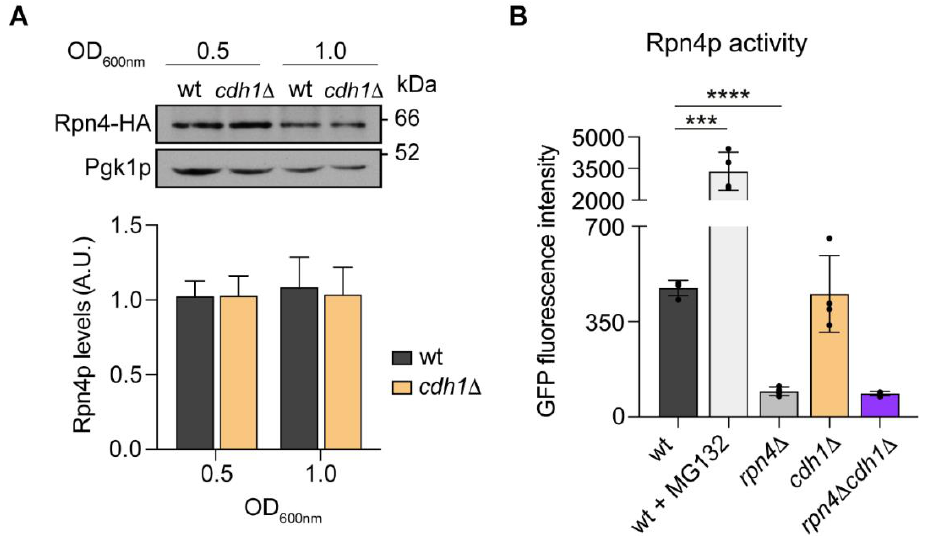
Figure 5. Rpn4p levels or activity are not altered in cdh1 ∆ mutant cells. ( A ) Wt or cdh1 ∆ cells endogenously expressing hemagglutinin (HA)-tagged Rpn4p were grown to early and mid-log phase and analyzed by immunoblotting using anti-HA and anti-Pgk1p (loading control) antibodies. A representative blot is shown. Graph represents the relative amount of Rpn4-HA normalized to Pgk1p. Values are the mean ± SEM ( n = 4). ( B ) Cells with the indicated genotypes harboring a GFP reporter for Rpn4p activity were grown to early-log phase. As a positive control, wt cells were treated with the proteasome inhibitor MG132. The GFP fluorescence intensity was determined by flow cytometry. The values are the mean ± SD ( n = 4), ***, p < 0.001; ****, p < 0.0001; t -test.